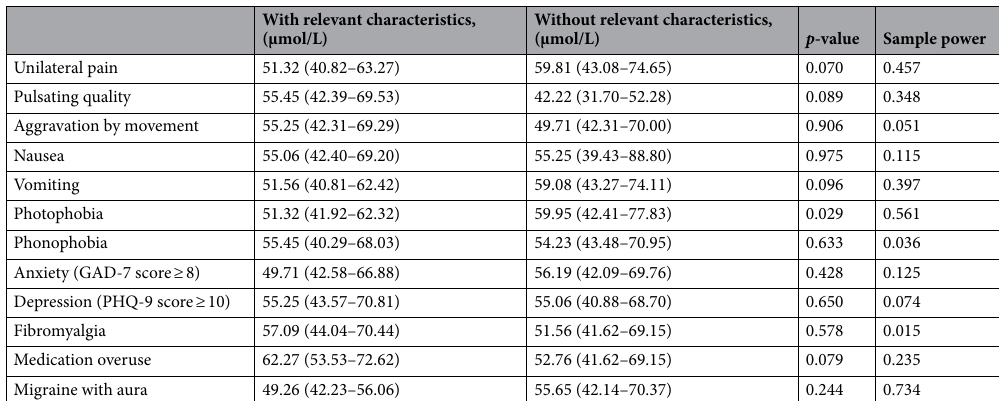
Table 3. Glutamate levels in participants with migraine according to clinical characteristics and comorbidities. GAD-7 Generalized Anxiety Disorder-7, PHQ-9 Patient Health Questionnaire-9.